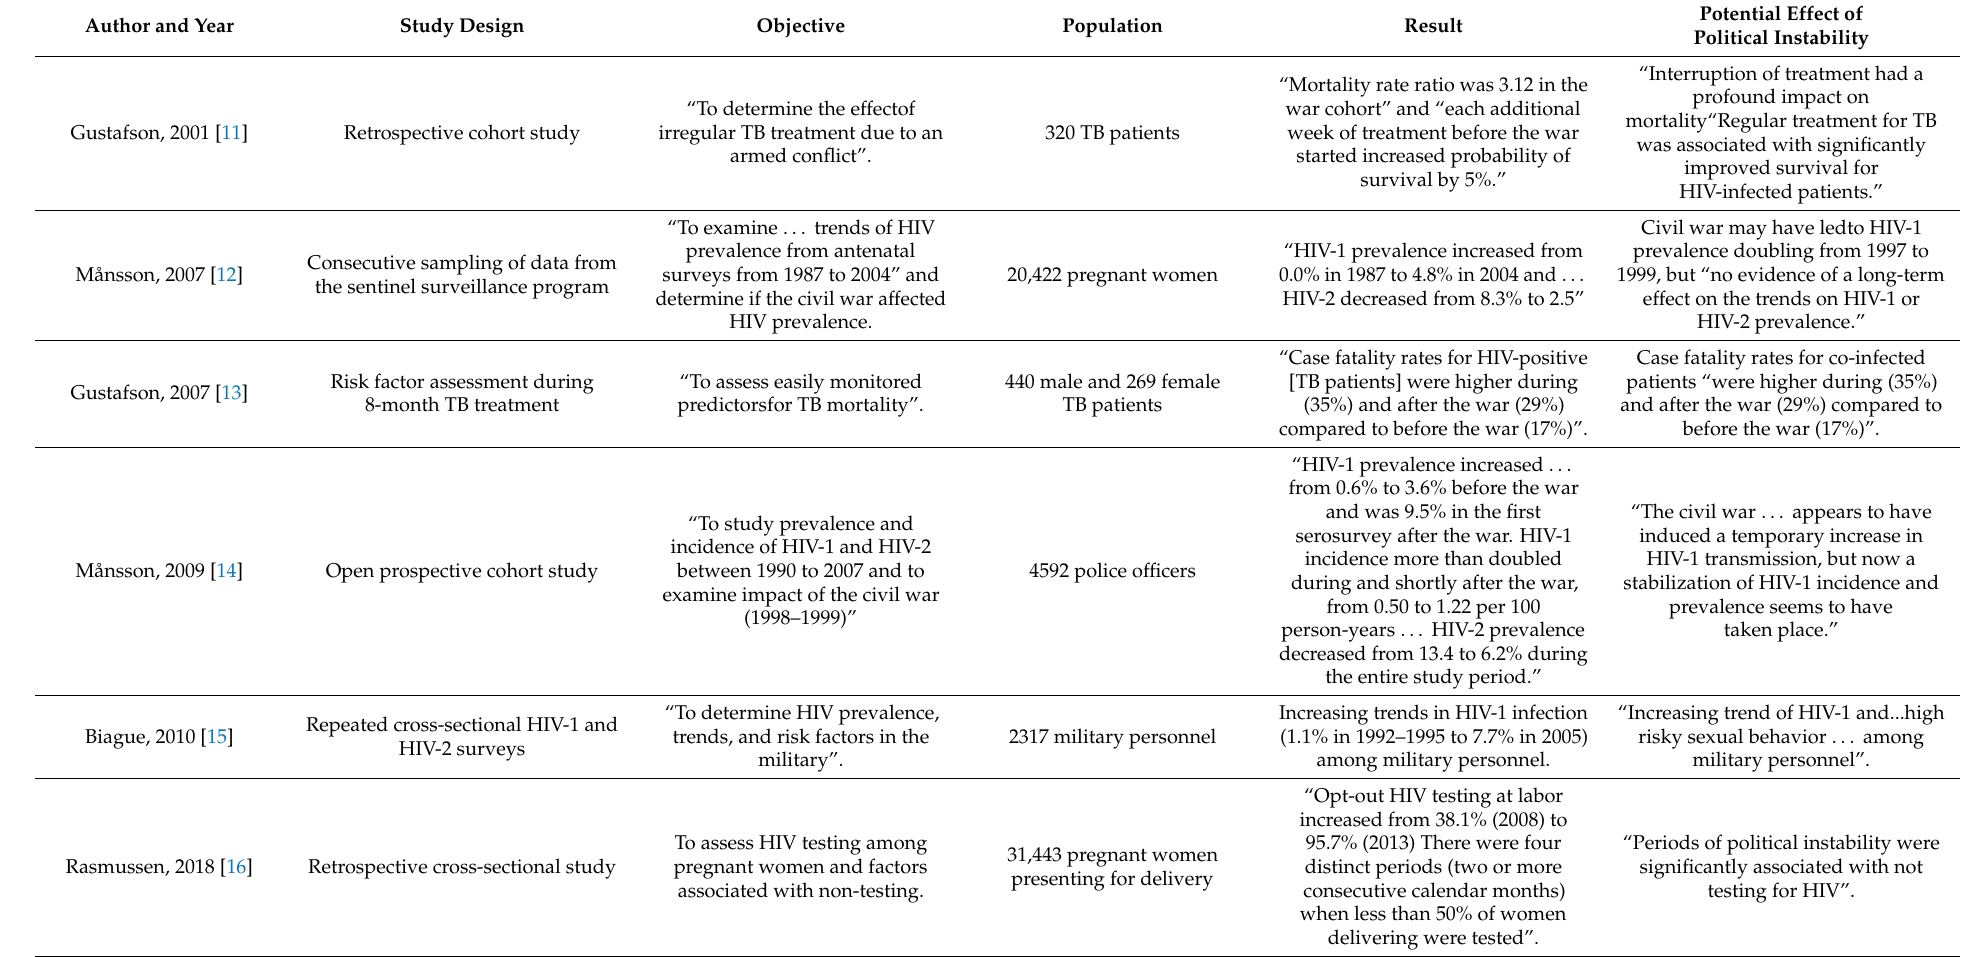
Table 4. Studies exploring relation between political instability and HIV/AIDS in Guinea-Bissau during the period of 2000–2015 in chronological order (n =